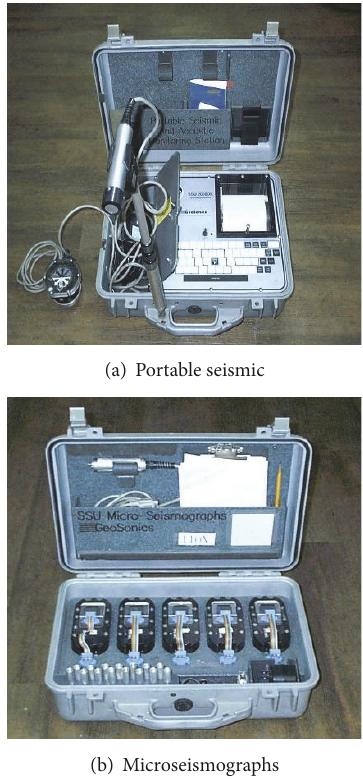
Figure 2: Shape of Geosonics